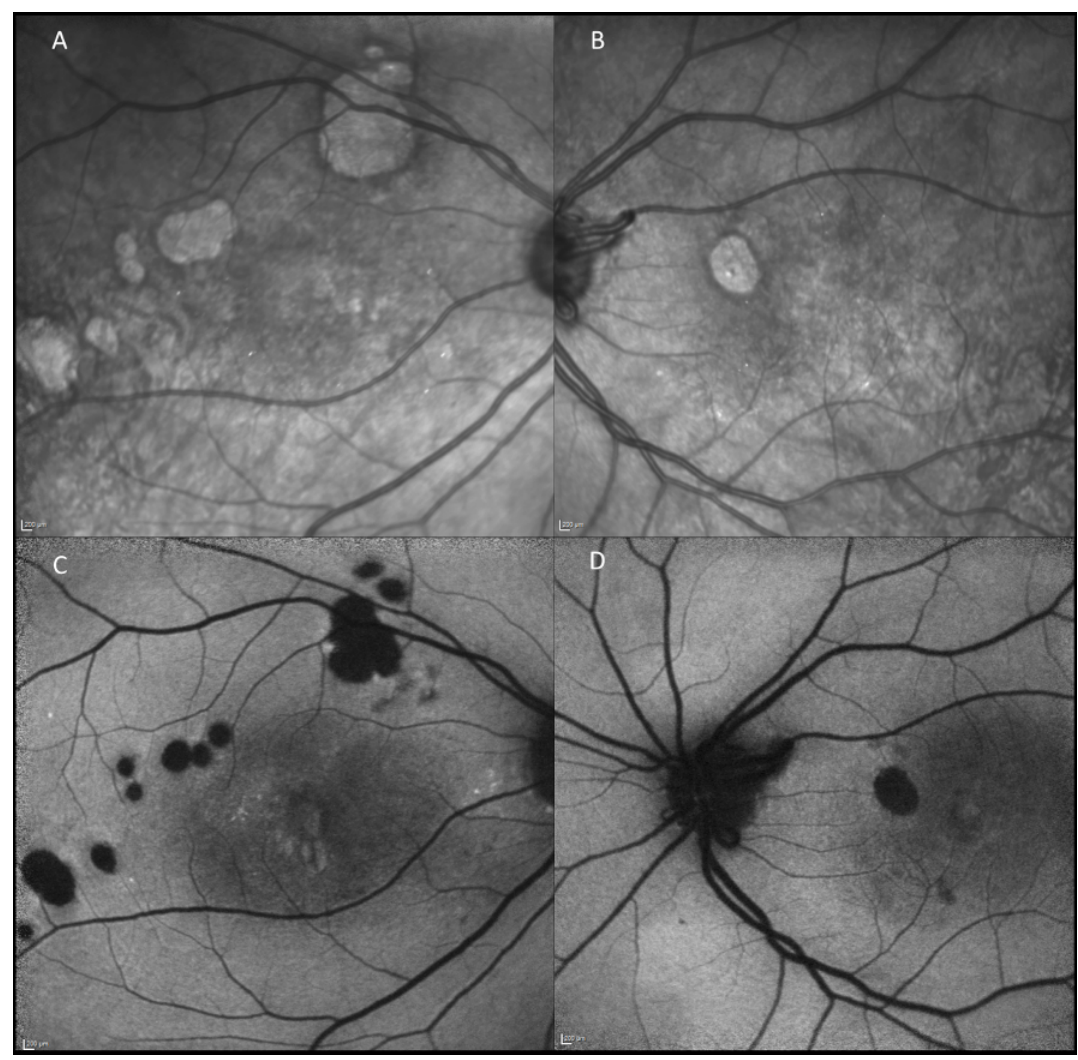
Figure 3: Infrared scanning laser ophthalmoscopy images: punctate hyperreflectivity (A, B). Fundus autofluorescense: hypoautofluorescence due to old laser scars (C,